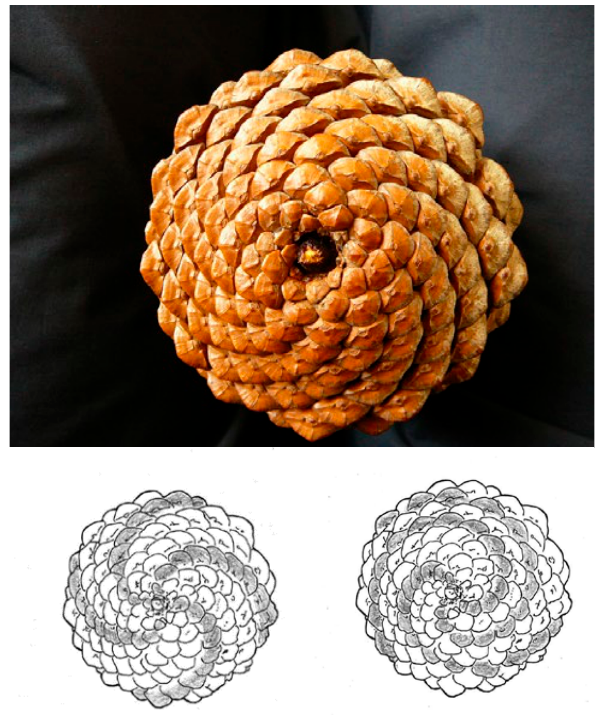
Figure 3. Cone of a Maritime pine ( Pinus pinaster ) growing in the western Mediterranean (above), showing an arrangement of the scales according to two series of spirals with a ratio 13 / 8 (below).